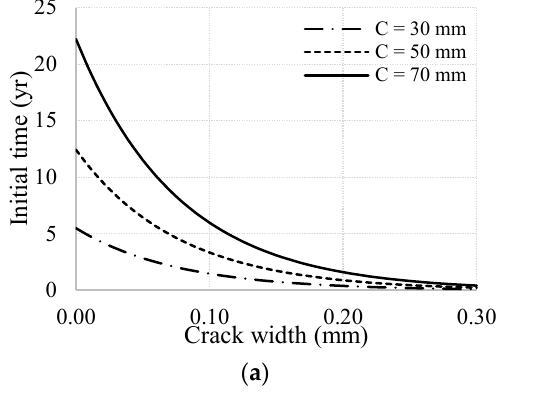
Figure 10. Initiation and propagation times in reinforced concrete sections: ( a ) Initiation time; ( b ) propagation time.